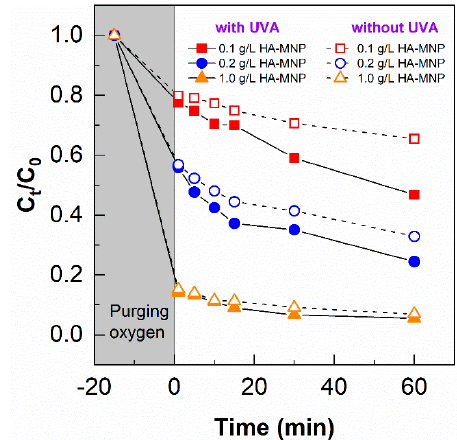
Figure 6. The removal of As(III) in the solution without and with UVA irradiation for 60 min. [HA-MNP] = 0.1, 0.2, and 1.0 g L − 1 ; [As(III)] 0 = 200 µg L − 1 ; pH = 6.0 ± 0.5.